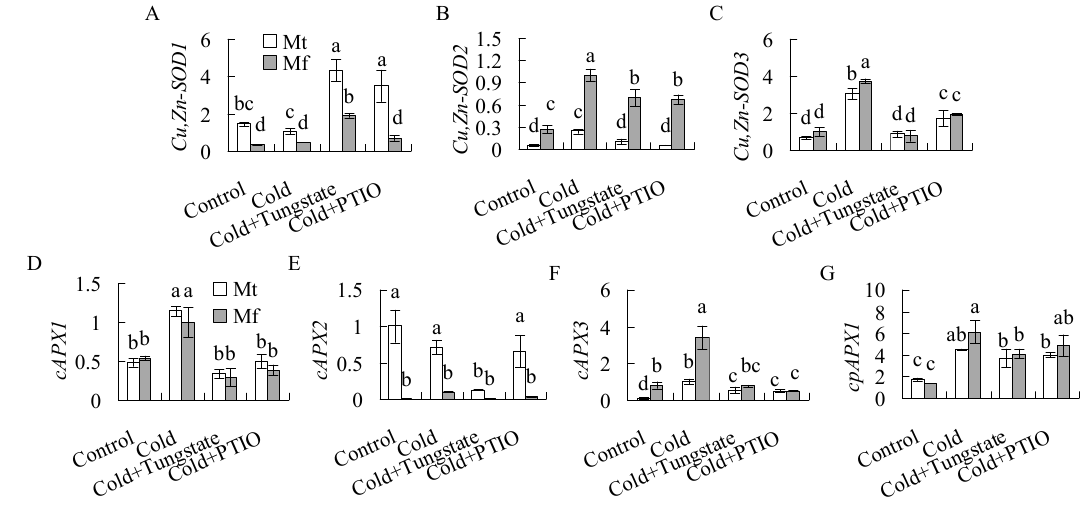
Figure 6. Antioxidant enzyme transcripts in response to cold treatment in M. falcata (Mf) in comparison to M. truncatula (Mt). Ten-week-old M. falcata and M. truncatula cv. A17 plants were irrigated with 15 mL of 1 mM tungstate or 100 µ M 2-phenyl-4,4,5,5,-tetramethylimidazoline-1-oxyl 3-oxide (PTIO) solution or H 2 O as a control, followed by exposure to 5 ◦ C for 24 h in a growth chamber. Cu,Zn-SOD1 ( A ), Cu,Zn-SOD21 ( B ), Cu,Zn-SOD3 ( C ), cAPX1 ( cytosolic APX , D ), cAPX2 ( E ), cAPX3 ( F ), and cpAPX1 ( chloroplast APX , G ) transcripts were detected using qRT-PCR, and actin was amplified as a reference gene to calculate the relative expression. Means of three replicates and standard errors are presented; the same letter above the column indicates no significant difference at p < 0 . 05.